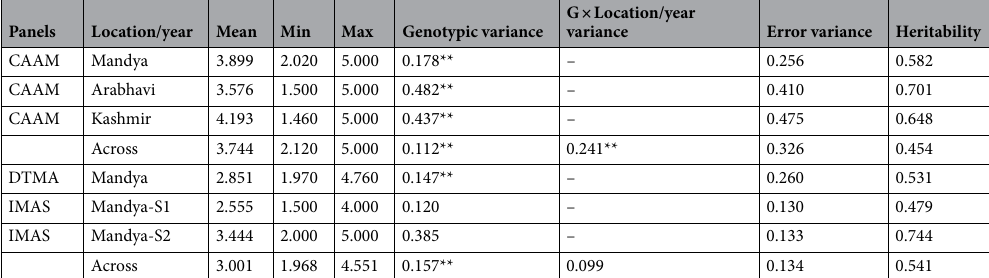
Table 2. Single and across locations summary statistics, variance components and heritability estimates of the Northern corn leaf blight (NCLB) scores for CIMMYT Asia Association Mapping (CAAM), Drought Tolerant Maize for Africa (DTMA) and Improved Maize for African Soils (IMAS) panels. ** P value ≤ 0.001.